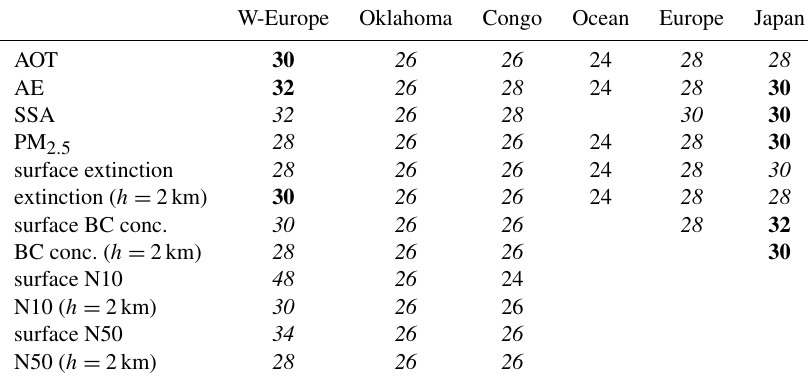
Figure 19. Daily representation errors after collocation: purely spatial sampling (grey), no collocation (brown), and model data collocated to the hour (red). Panel (a) is for a ground site, (b) for a satellite with a 1 day repeat cycle. Further explanation in Sect. 3.2. Table 4. Optimal averaging periods for ground-site measurements used to represent a 210 × 210km 2 area (daily). The font types indicate an increase of representation RMSD representation of less than 5% (italic font), less than 10% (bold font) or less than 20% (underlined) when using the recommended period of 24h instead. W-Europe